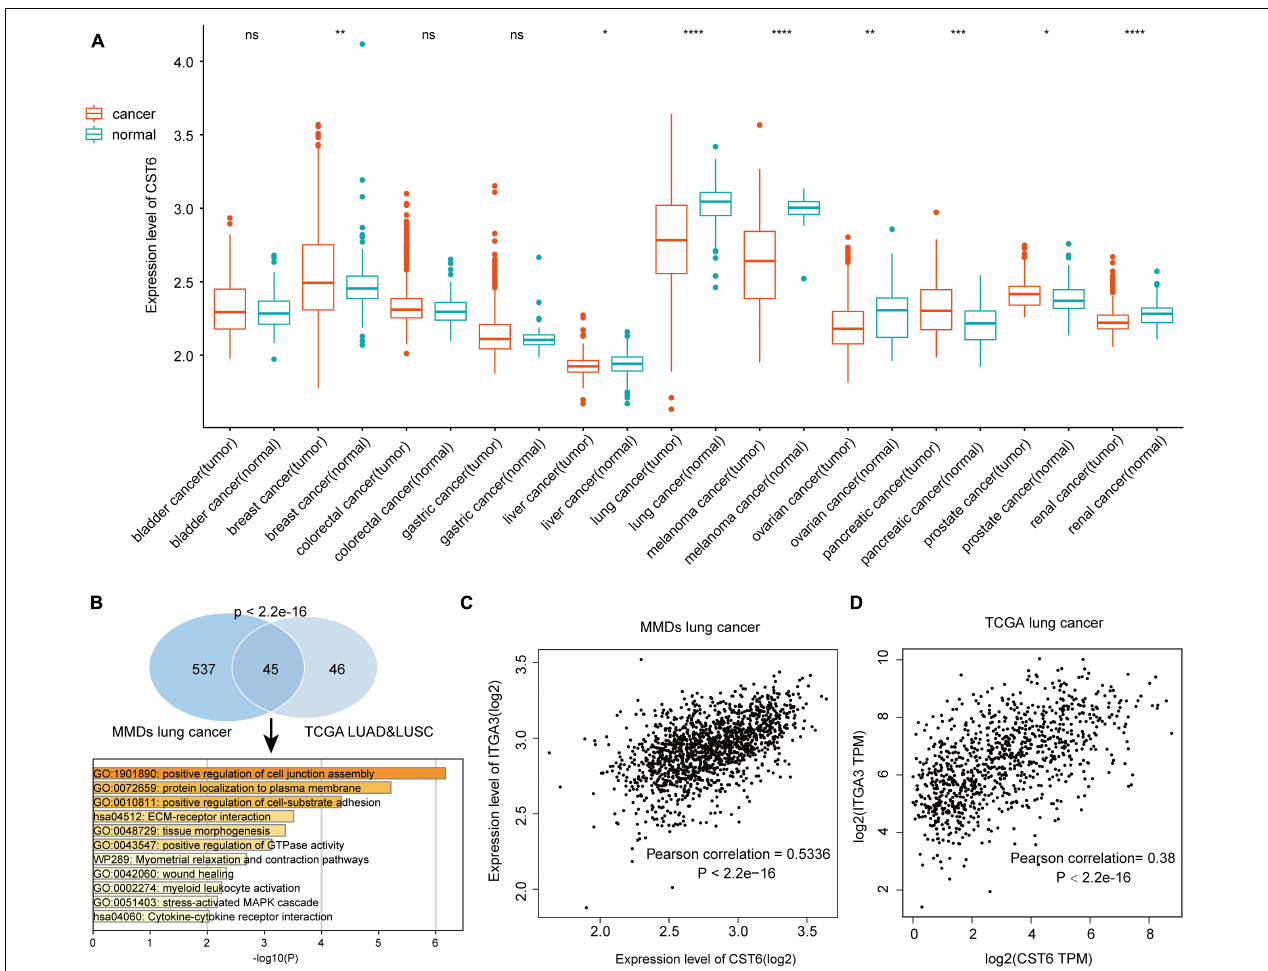
FIGURE 2 | Expression level of CST6 in Merged Microarray-acquired Datasets (MMDs) datasets. (A) The expression level of CST6 in different cancer types from MMDs.* p < 0.05; ** p < 0.01; *** p < 0.001; **** p < 0.0001; ns, not significant. (B) The comparison and functional analysis of CST6-related genes between MMDs lung cancer and TCGA lung adenocarcinoma (LUAD) and lung squamous cell adenocarcinoma (LUSC) datasets. (C,D) The correlation between the expression of CST6 and integrin α 3 (ITGA3) for lung cancer in MMDs and TCGA